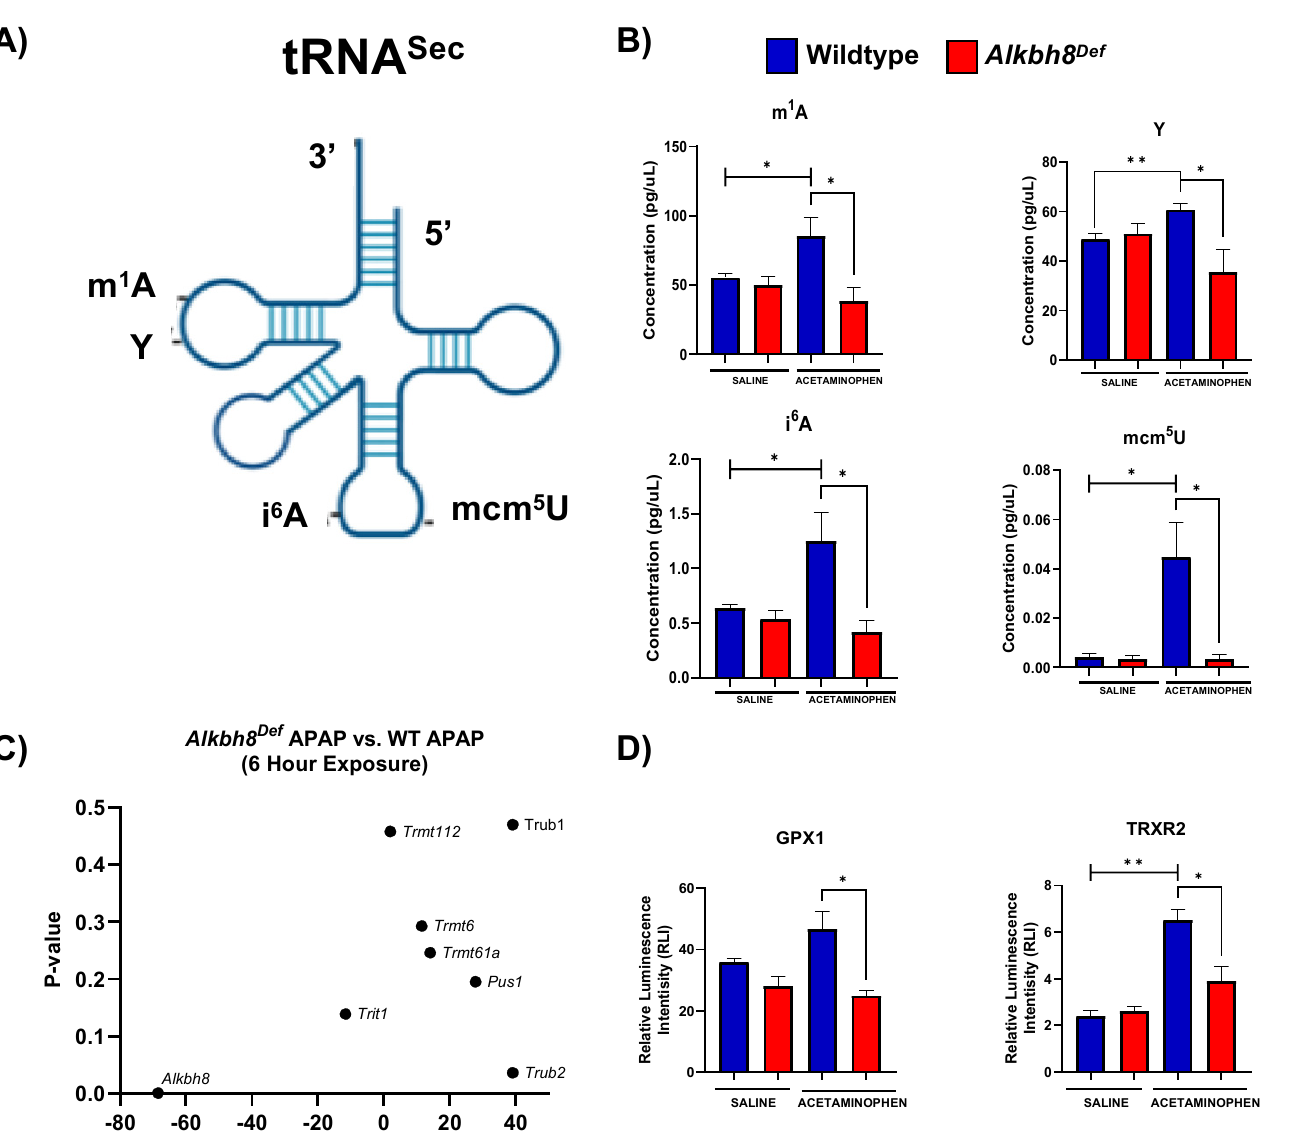
Figure 4. Multiple RNA modifications on tRNA for selenocysteine and other tRNAs are differentially regulated in WT and Alkbh8 Def livers in response to a single dose of APAP. ( A ) Epitranscriptomic marks found on tRNA Sec . ( B , C ) WT and Alkbh8 Def mice (N = 3) were exposed to a single dose of APAP and livers were harvested 6 h after dosing. ( B ) Modifications that occur throughout tRNA Sec and other tRNAs were measured using LC-MS/MS. ( C ) Writer enzyme gene count changes in expression vs. p-value determined. ( D ) Selenoprotein levels (N = 3) were evaluated using the ProteinSimple WES system. Statistical significance was determined using an unpaired t -test with (* p < 0.05, ** p <